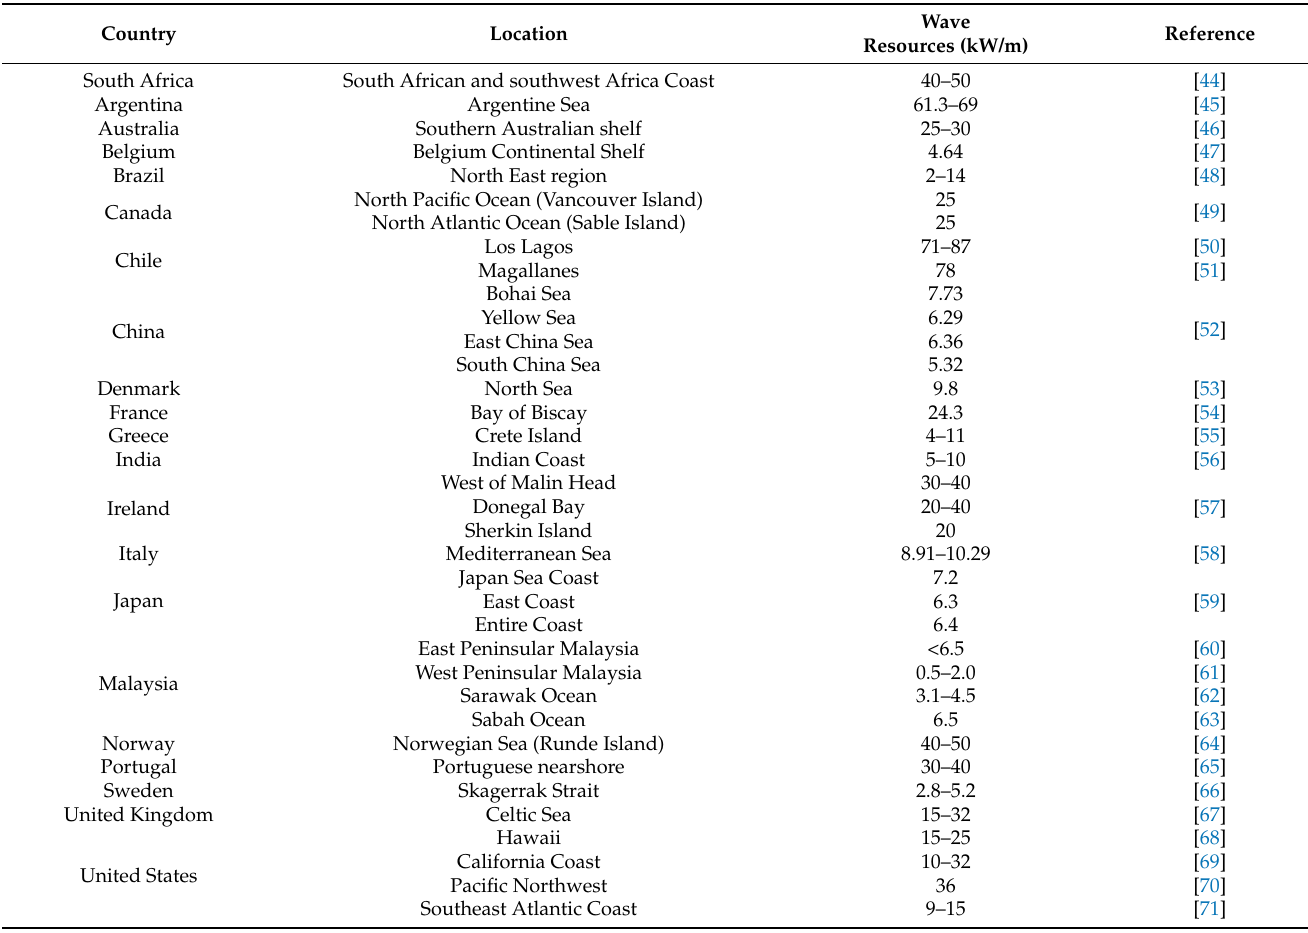
Table 2. Wave energy resources in different coastal areas across different countries.